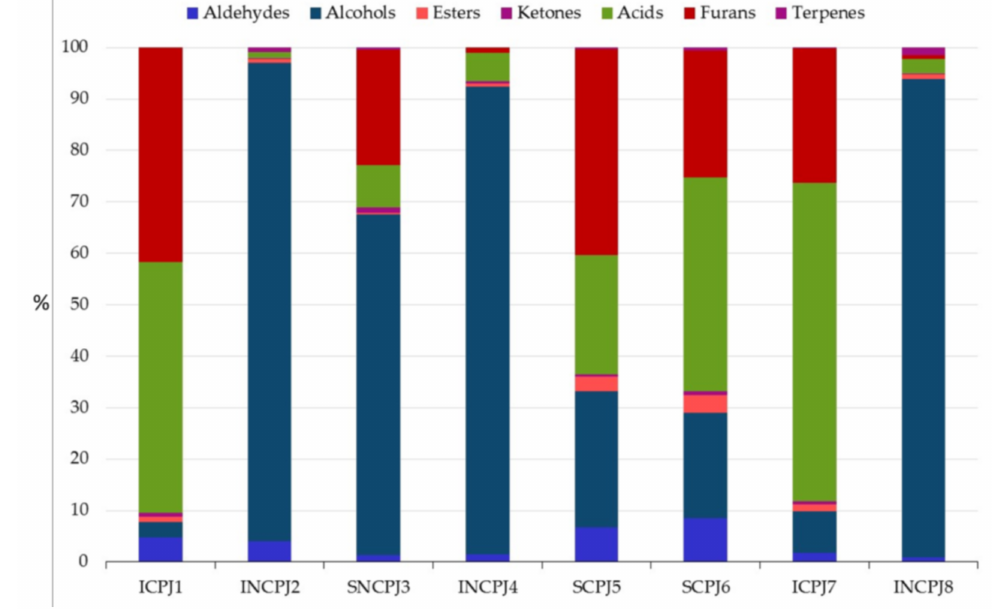
Figure 2. Distribution (%) of the volatile compounds of PJs analysed. The other families of volatile compounds constituted a small part of the total con- tent: aldehydes represented 3.7%, with benzaldehyde and 3-methylbutanal as the most abundant, except for sample 3, where higher concentrations of acetaldehyde were found. Esters, almost exclusively represented by methyl benzoate, contributed 1.4% of the total. The only ketone found was acetoin, with 0.5% of the total volatile compounds content.